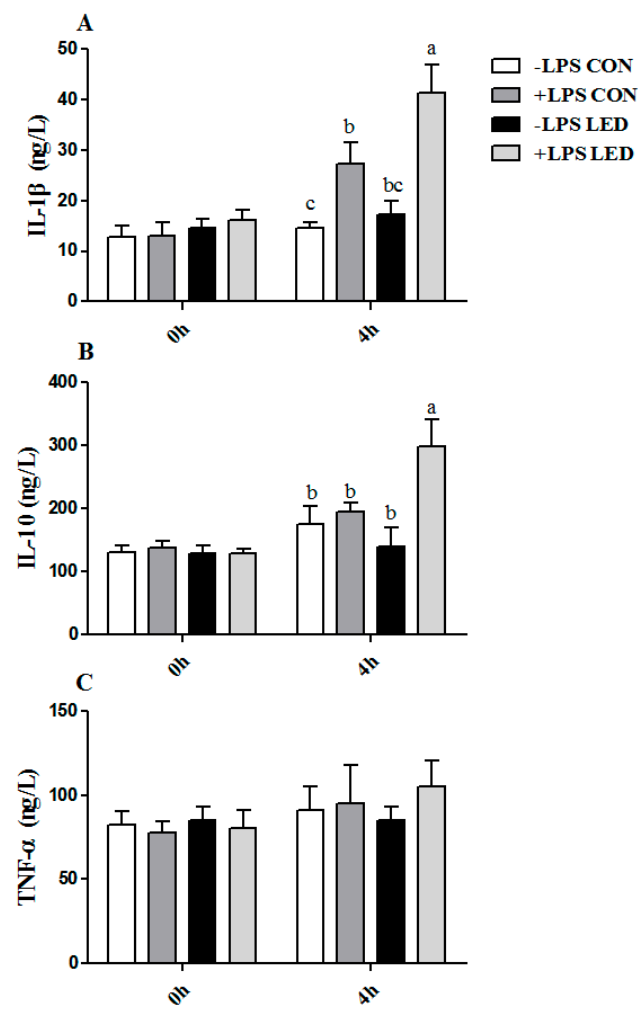
Figure 7. Effect of different energy levels during gestation on plasma IL-1 β ( A ), IL-10 ( B ), and TNF- α ( C ) concentrations of weaned piglets challenged with Escherichia coli lipopolysaccharide. Values are expressed as mean values with their standard errors; means with different superscript letters are significantly different ( p < 0.05); the replicated number of each group is 6.